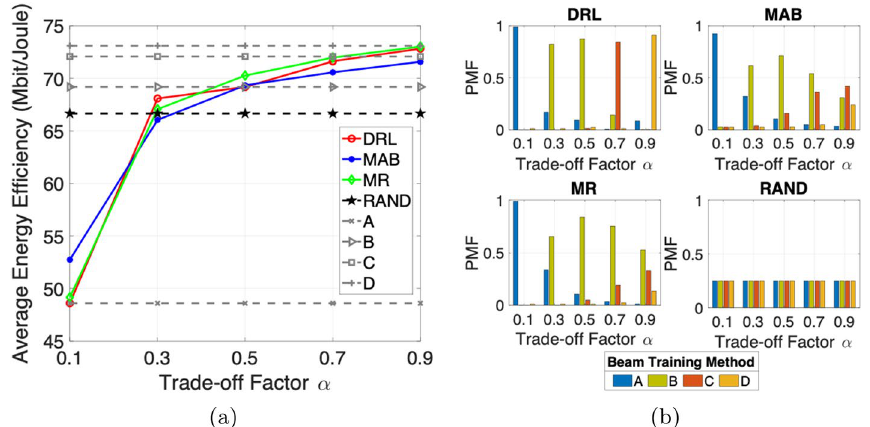
Fig. 8 Performance for different beam training policies with different trade-off factors α for DRL-EE. a Average EE v.s. α . b PMF of actions v.s.